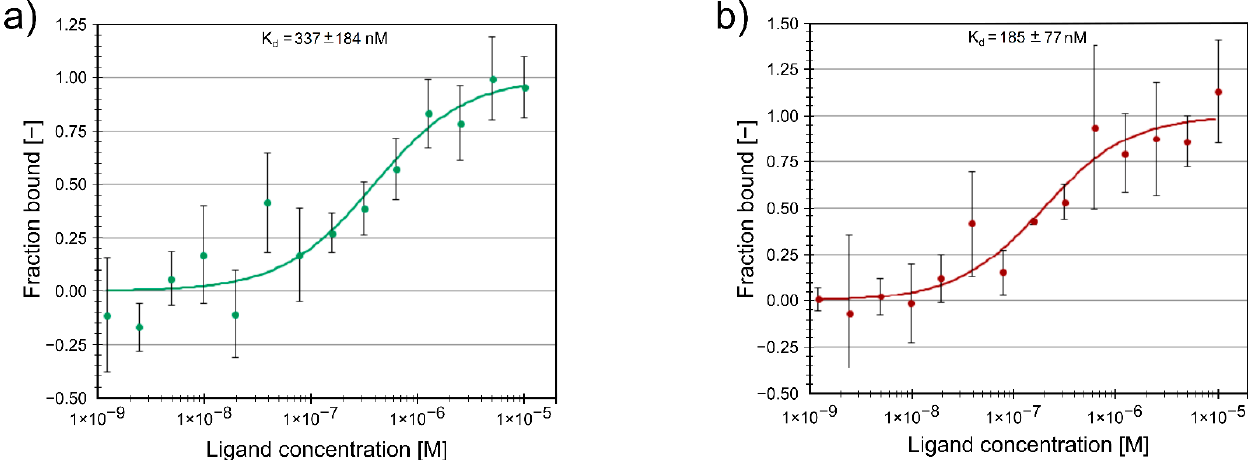
Figure 6. Two inhibitors directly interact with FTO protein as shown by microscale thermophoresis. ( a ) Unlabeled titrated compound 2 (0–10 µM) interacts with Alexa647-labeled through His-tag FTO (20 nM). ( b ) Unlabeled titrated compound 3 (0–10 µM) interacts with Alexa647-labeled through His-tag FTO (20 nM). For ( a , b ) microscale thermophoresis binding curves, showing fraction bound values from n = 3 individual repeats per binding pair ± SEM, K d values ± error estimations are indicated.